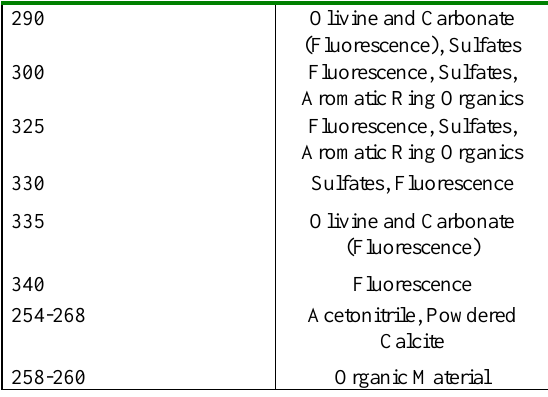
Figure 5. PC1 vs. PC3 (Region-1)